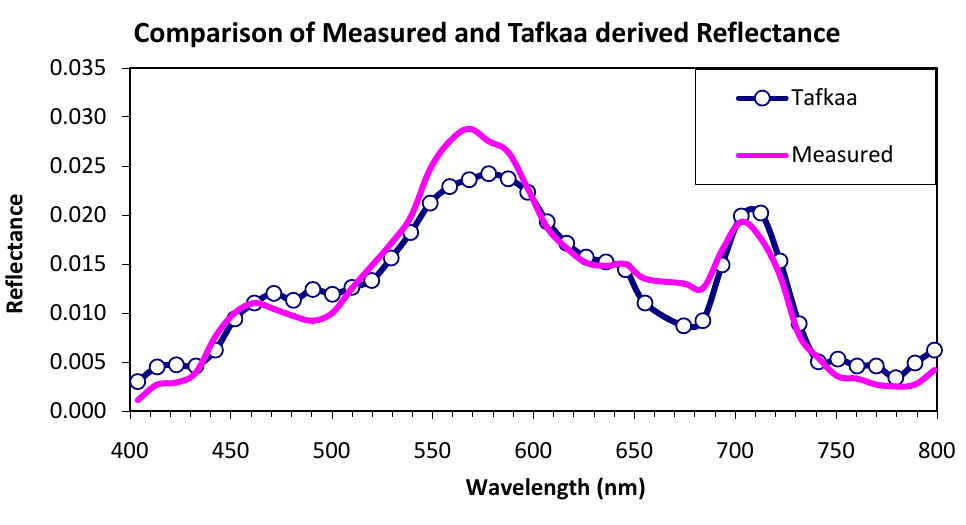
Figure 2. Comparison of reflectance spectra measured by the field spectroradiometer (OL754) and Tafkaa derived AVIRIS spectra for sampling station 1 (Figure 1). ( Note: The ―in-water‖ measured spectra are produced by a submersible spectroradiometer as point location and Tafkaa derived reflectance spectra are based on AVIRIS data with spatial resolution of 20 m × 20